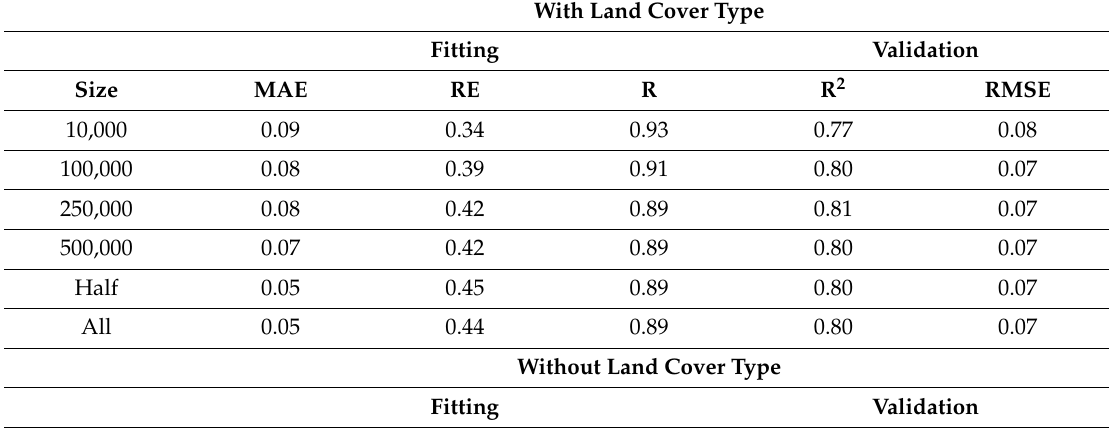
Table 1. The statistical measures for model development and validation. All the models were developed with training samples in 2015 and 2016 and validated with testing data in 2017. MAE, RE, and R represent mean absolute error, relative error, and correlation coefficient, respectively. R 2 and RMSE represent the coefficient of determination and root mean squared error, respectively. MAE, RE, and R are used for fitting, while R 2 and RMSE are used for validation.